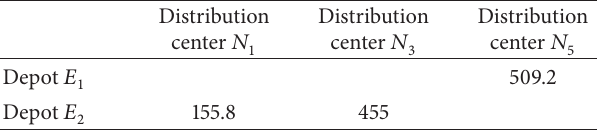
Table 6: The amount that is supplied to distribution centers (t/year).